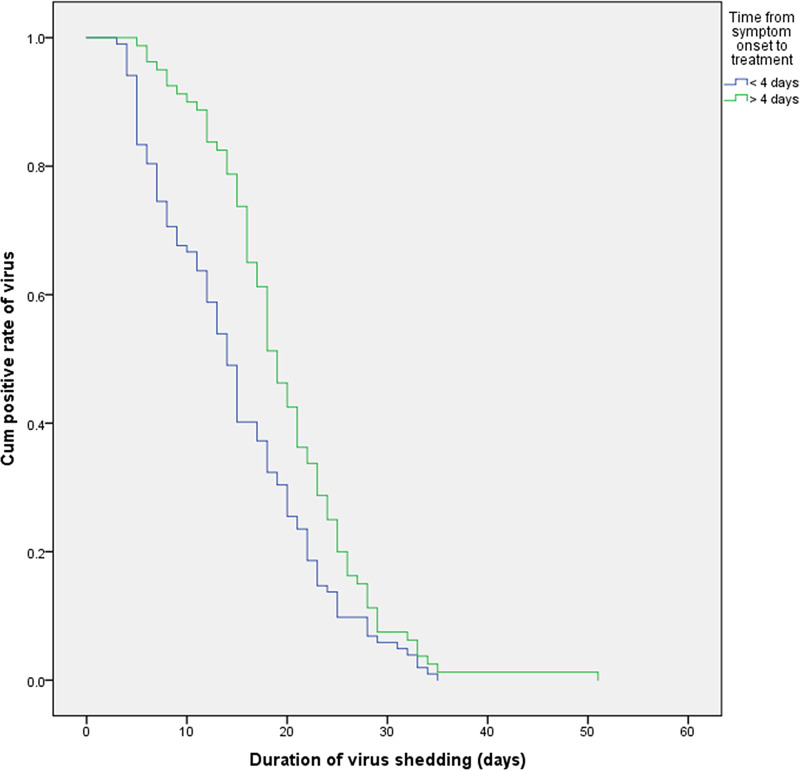
Kaplan–Meier plot for the time from symptom onset to treatment.